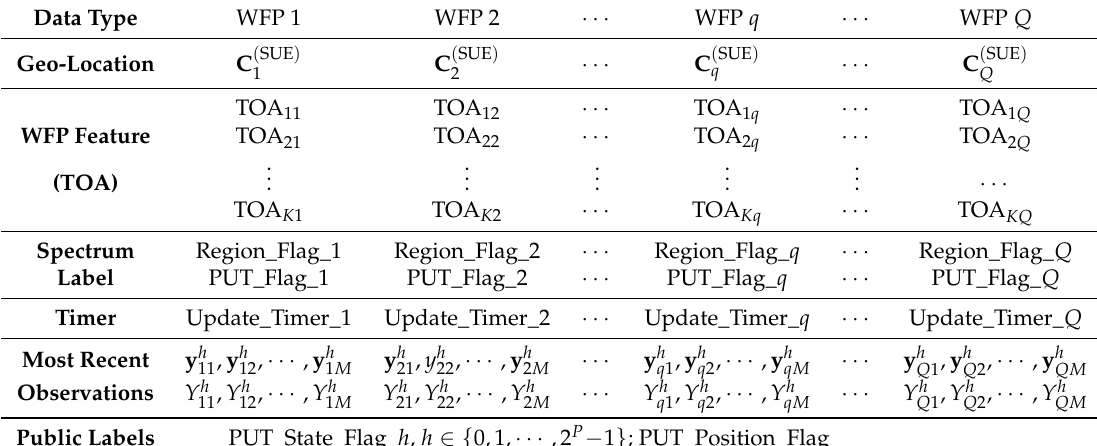
Table 2. Data table of the time of arrival (TOA) wireless fingerprint